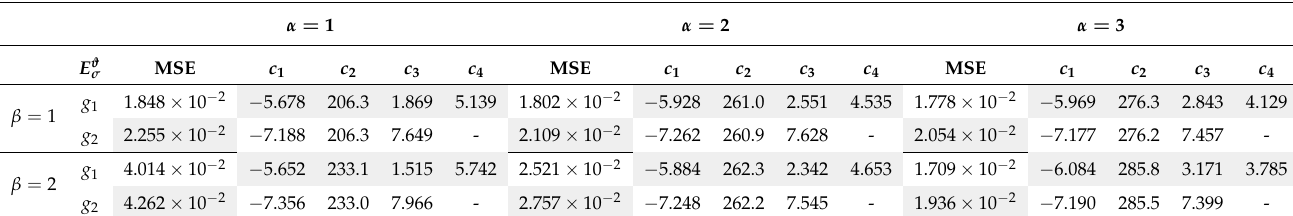
Table 2. DFN158. Mean Square Error (MSE) and coefficients of the least square minimization with respect to E ϑ σ . α = 1 α = 2 α =